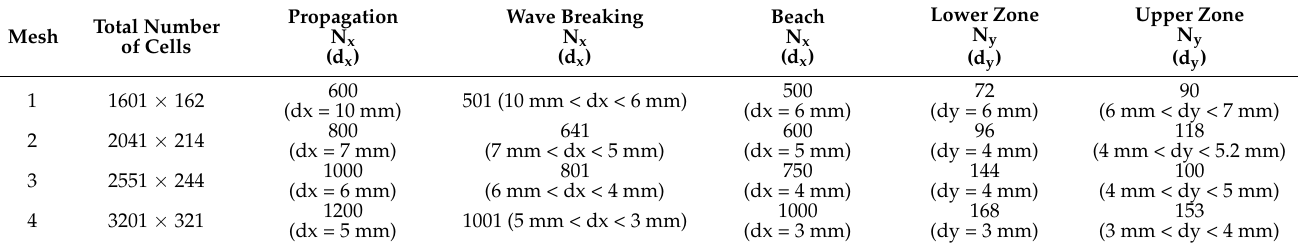
Table 6. IH2VOF mesh characteristics.